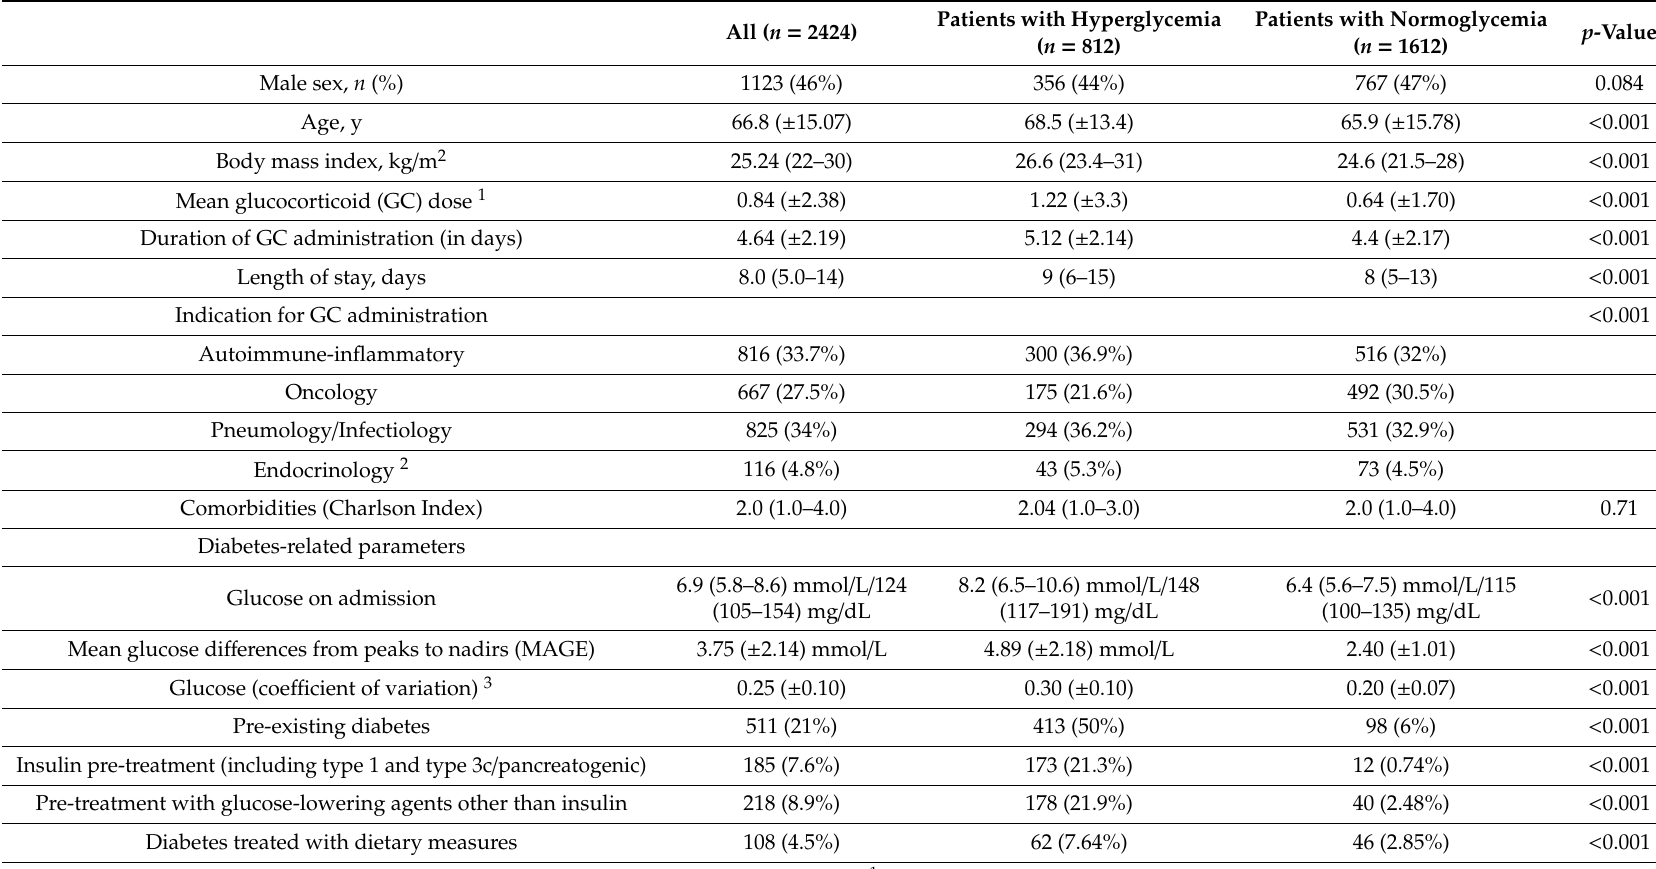
Table 1. Baseline